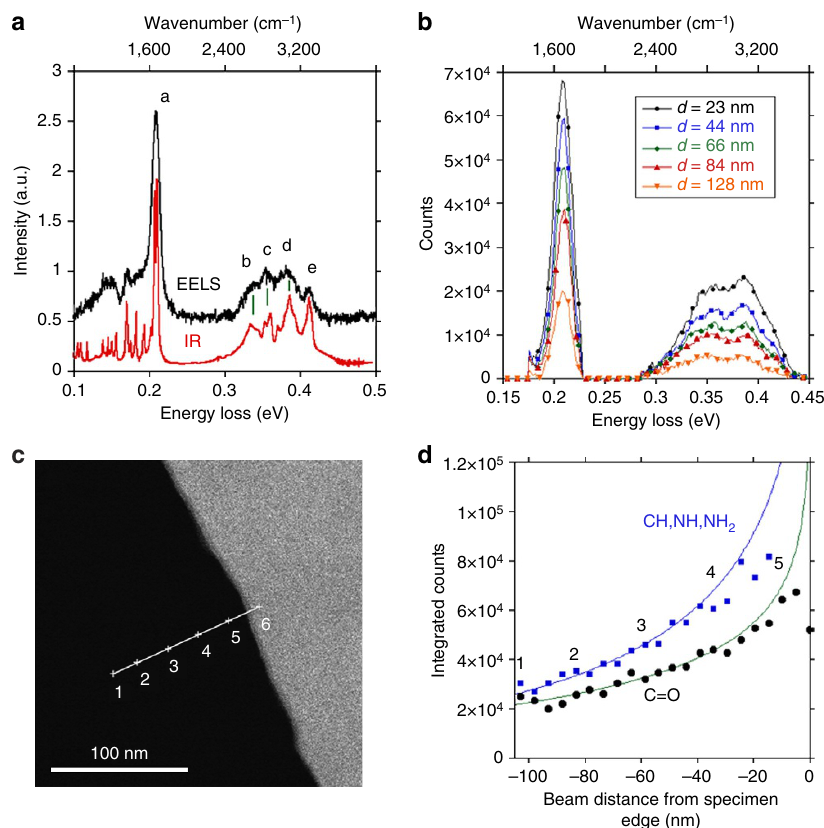
Figure 2 | Variation of infrared region spectra with electron beam position. ( a ) An EEL spectrum at the infrared region, collected when the electron probe is 30nm from the edge of the crystal, compared with an ex situ FTIR spectrum. Peaks corresponding to C ¼ O, NH, CH , NH 2 symmetric and NH 2 antisymmetric stretches can be seen in the EEL spectrum, matching corresponding features in the FTIR (Table 1). ( b ) A set of spectra showing how the peaks in the infrared region increase in height as the probe is moved closer to the specimen. ( c ) Dark-field image showing guanine crystal–vacuum interface and line along which spectra were taken. ( d ) Variation of total intensity of the C ¼ O peak (circles) and the combination of CH, and NH and NH 2 peaks (squares, peaks b–e from ( a )) from the EELS signal as the probe approaches the sample compared with the theoretical variation derived from classical dielectric theory given as equation (2) (solid lines). The acquisition time was 1.6s a point. Table 1. The most prominent feature is the peak from the C ¼ O Table 1 | Assignment of peaks observed by aloof EELS in the stretch at 209 meV. All the peaks that can be attributed to infrared region.